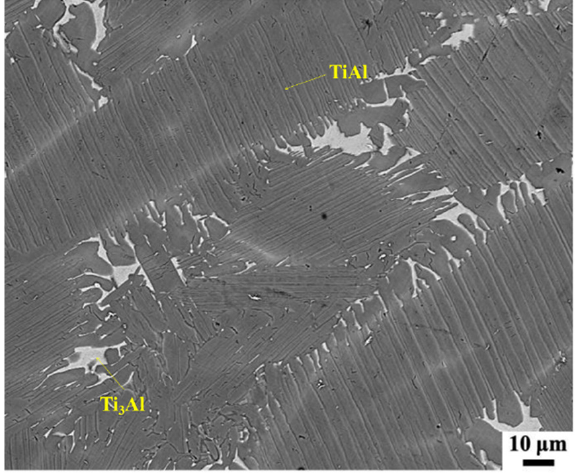
Figure 2. SEM image of the TiAl alloy.